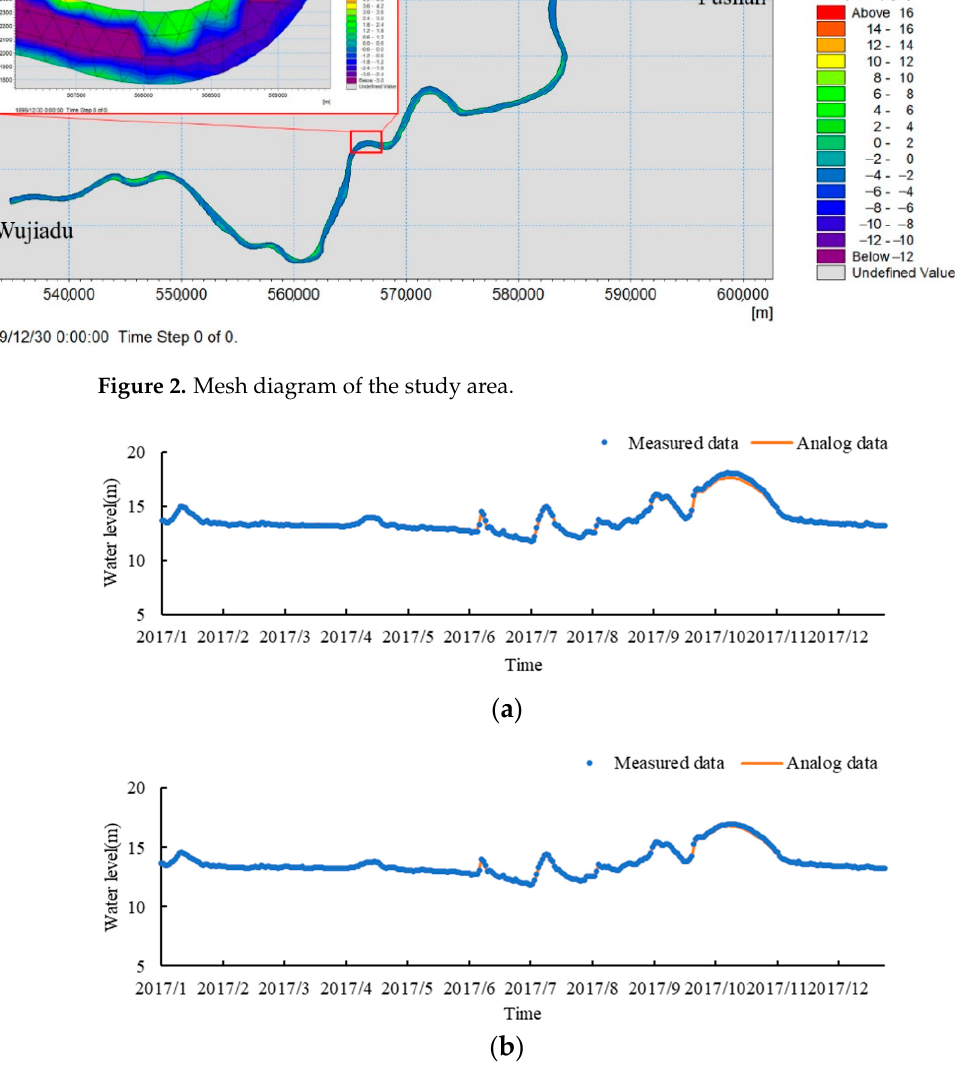
Figure 3 . Comparison of water level at the two stations: ( a ) Linhuaiguan; ( b )Wuhe. Table 2. Calculation of the error rating